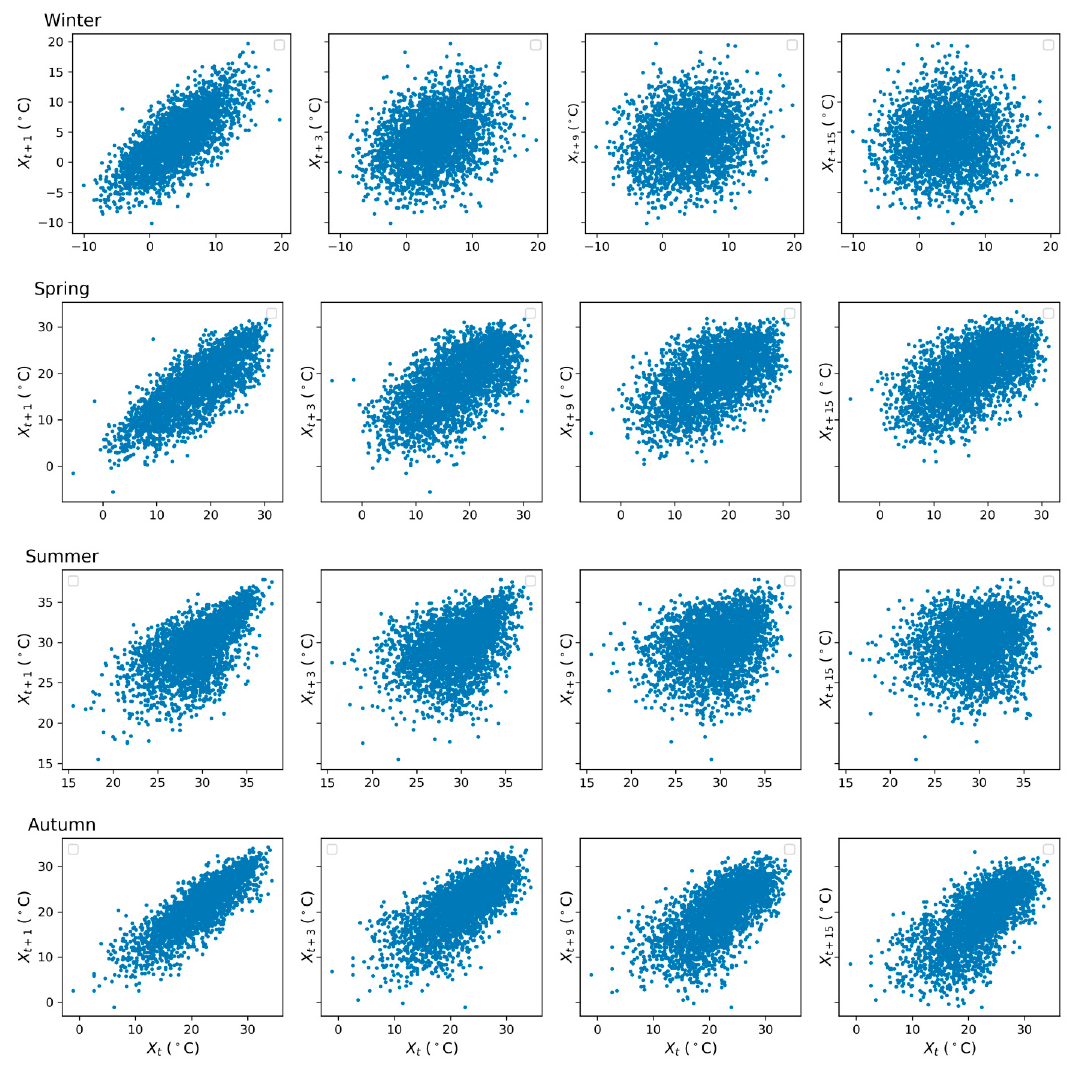
Figure 4. Scatter plots of the observed daily maximum temperature (cid:1850) (cid:3047) and (cid:1850) (cid:3047)(cid:2878)(cid:3038) , (cid:1863) = 1,3,9,15 in winter, spring, summer, and